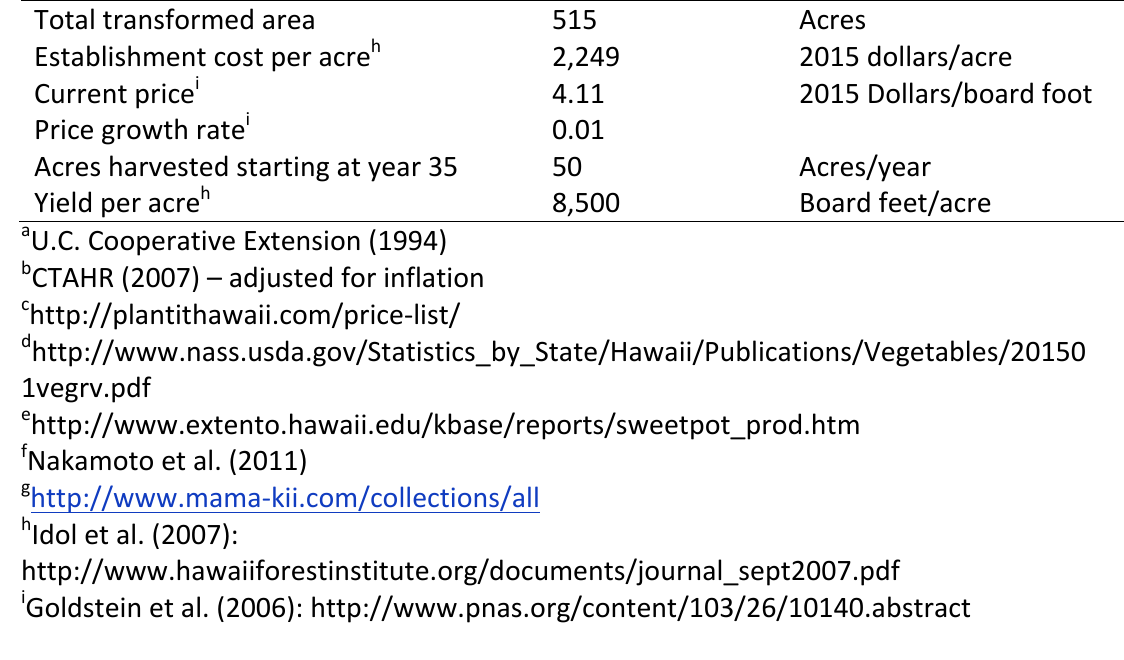
Table A1.11. Annual revenue and costs for Hawaiian agroforestry